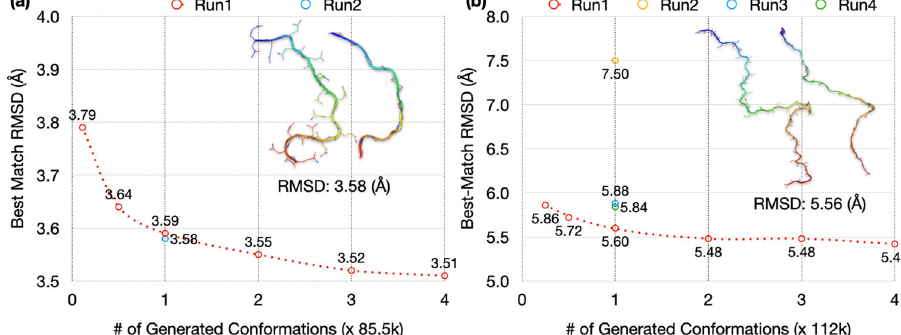
Fig. 4 Best-match RMSDs for autoencoder-generated conformations of Q15 and A β 40. The average best-match RMSDs of 100-fold diluted test sets of ( a ) Q15 and ( b ) A β 40, against generated sets at different sizes. The latter sizes are measured in multiples of the test size of each IDP ( = 85,500 for Q15 and 112,000 for A β 40). For run1, results are shown at sizes of the generated set ranging from the training size to 4×. For other MD runs, results are shown at 1×. In the inset of each panel, an IDP conformation and its generated best match, with an RMSD close to the average values at 1×, is